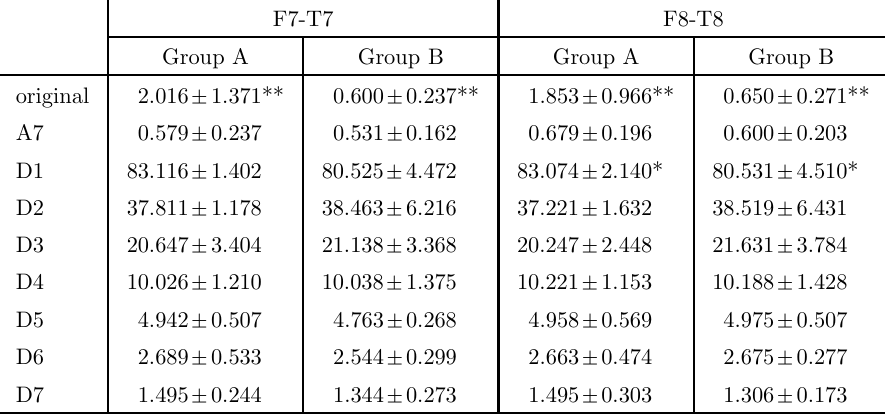
Table 1. The results of dominant frequencies for signals from channels F7-T7 and F8-T8 in studied groups (Mann-Whitney test) F7-T7 F8-T8 Group A Group B Group A Group B original